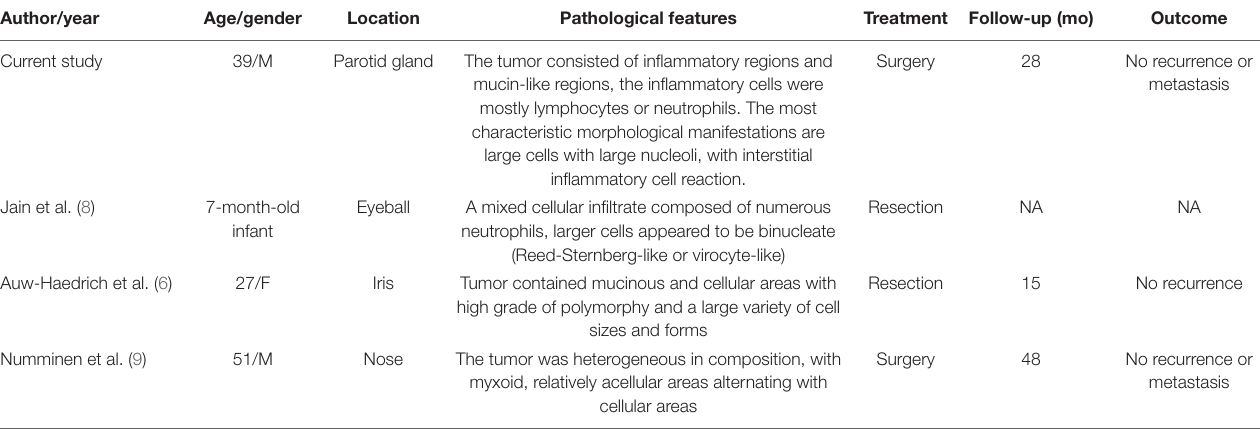
TABLE 2 | A summary of clinicopathological features of MIFS reported in the literature from the rare sites (non-bone and soft tissue, reviewed since